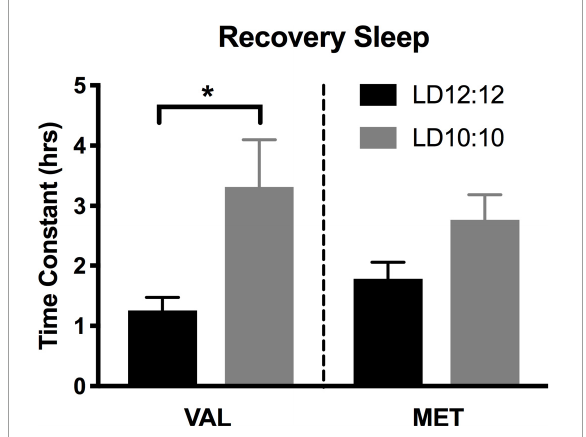
FIGURE5 Time constant of recovery sleep in Met mice is different than in Val mice. Graphs depict the time constant (tau) during recovery sleep. In Val mice, tau during recovery sleep was significantly longer after 20 days of LD10:10 ECD when compared to the LD12:12 recovery period. No statistically significant difference in tau was found in the Met mice. One-way ANOVA; * p <